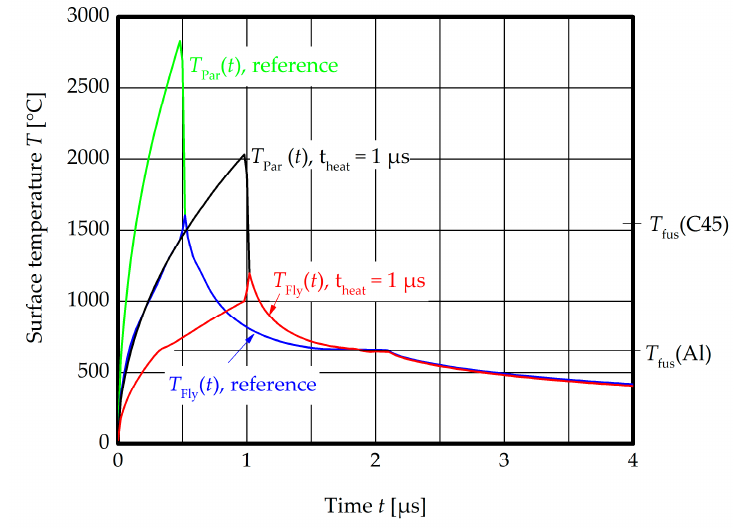
Figure 19. Comparison of T Fly ( t ) and T Par ( t ) for the reference setup and the setup with 1 µs heating time.